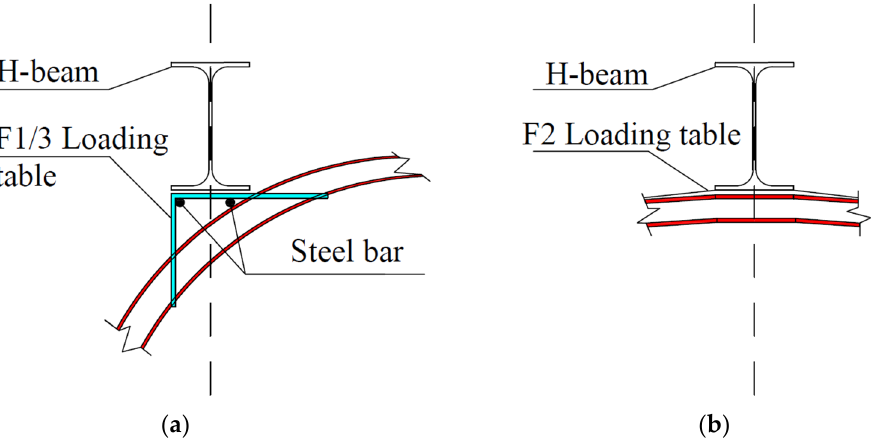
Figure 5. Stress diagram of test model. ( a ) F1/F3 loading table; ( b ) F2 loading table. F1 is the loading point at the arch quarter span; F2 is the loading point at the midpoint of the arch; F3 is the loading point at the three-quarter arch span.